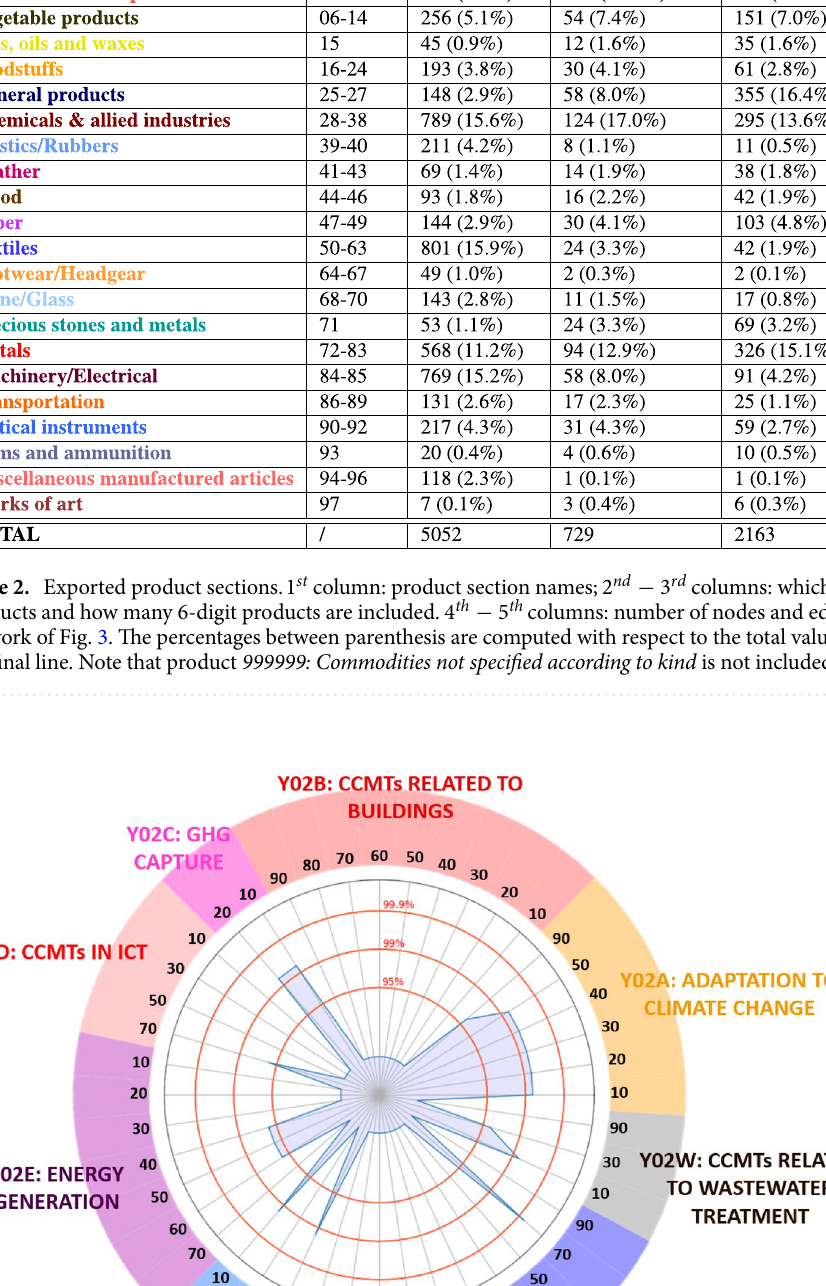
Figure 4. Focus on the export of Cobalt and other intermediate products of cobalt metallurgy (Harmonized System code 810520). Along the circular border of the figure, the CPC codes of the 44 green technology groups are labeled. Within the figure, three concentric circles delimit the significance levels of 99.9%, 99% and 95% respectively. Each peak in blue that exceeds the level delimited by one of the inner circles corresponds to a link that cobalt has with the green technology described in the